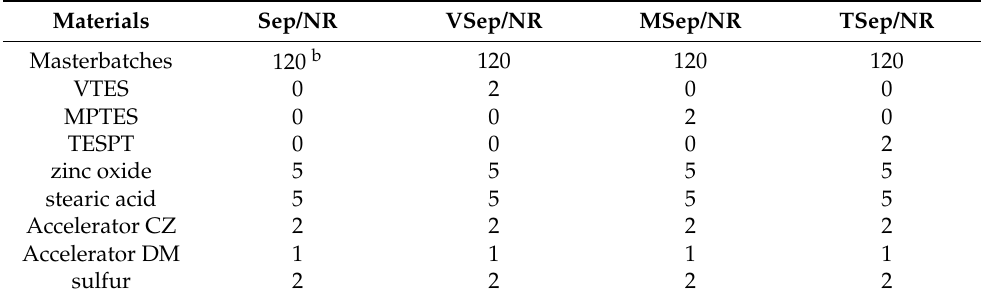
Table 2. Formulation of sepiolite/NR composites, phr a